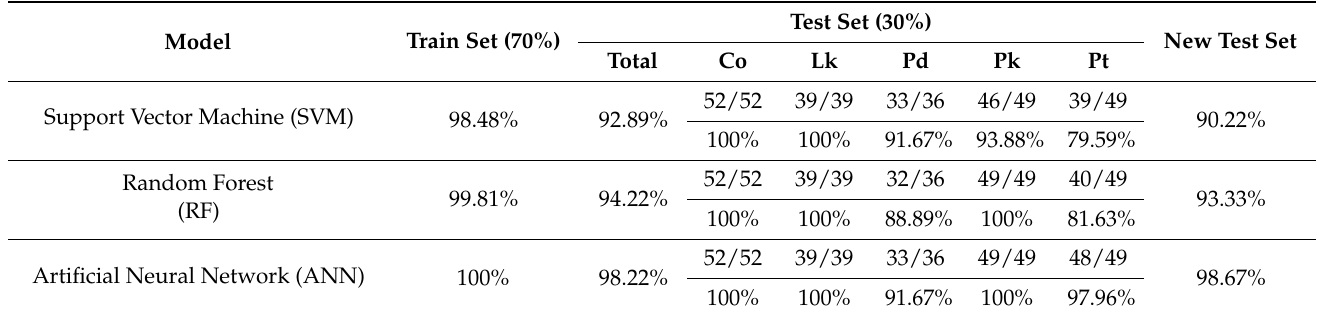
Table 1. Classification accuracies for training, test, and new test set data for each machine learn- ing model.